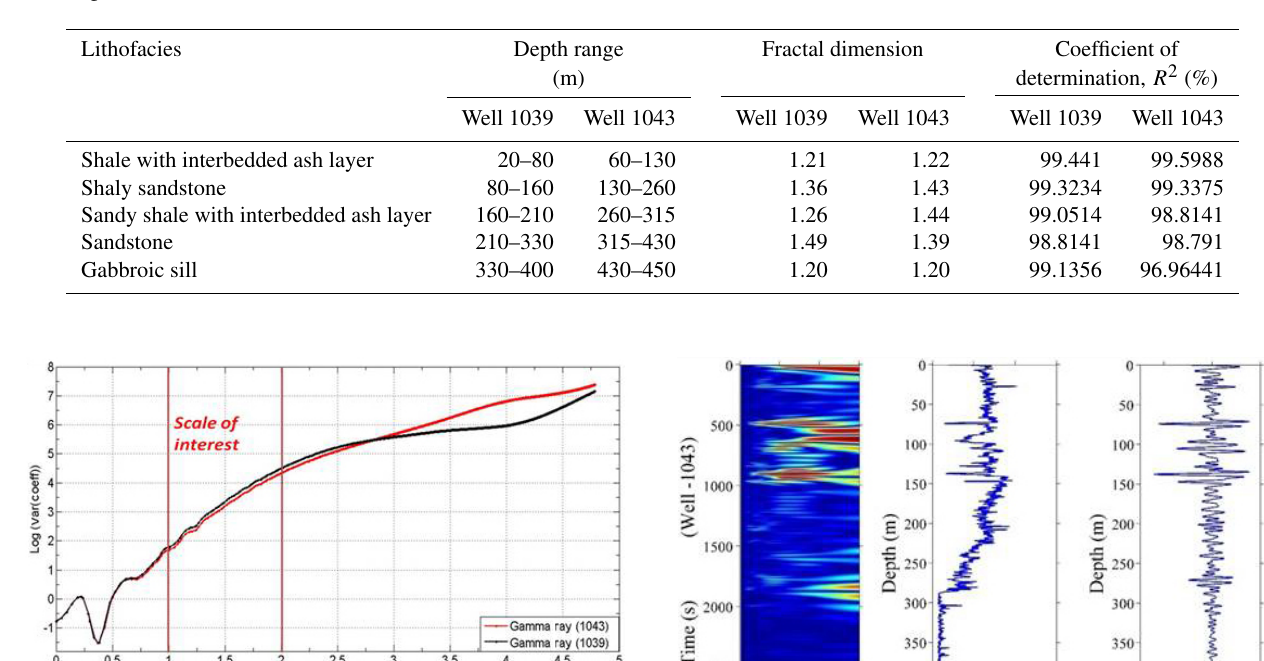
Table 1. FD values of the appropriate lithology identified, as well as the circled depth range and its appropriate fractal-dimension values, showing deviation from the reference site 1039.